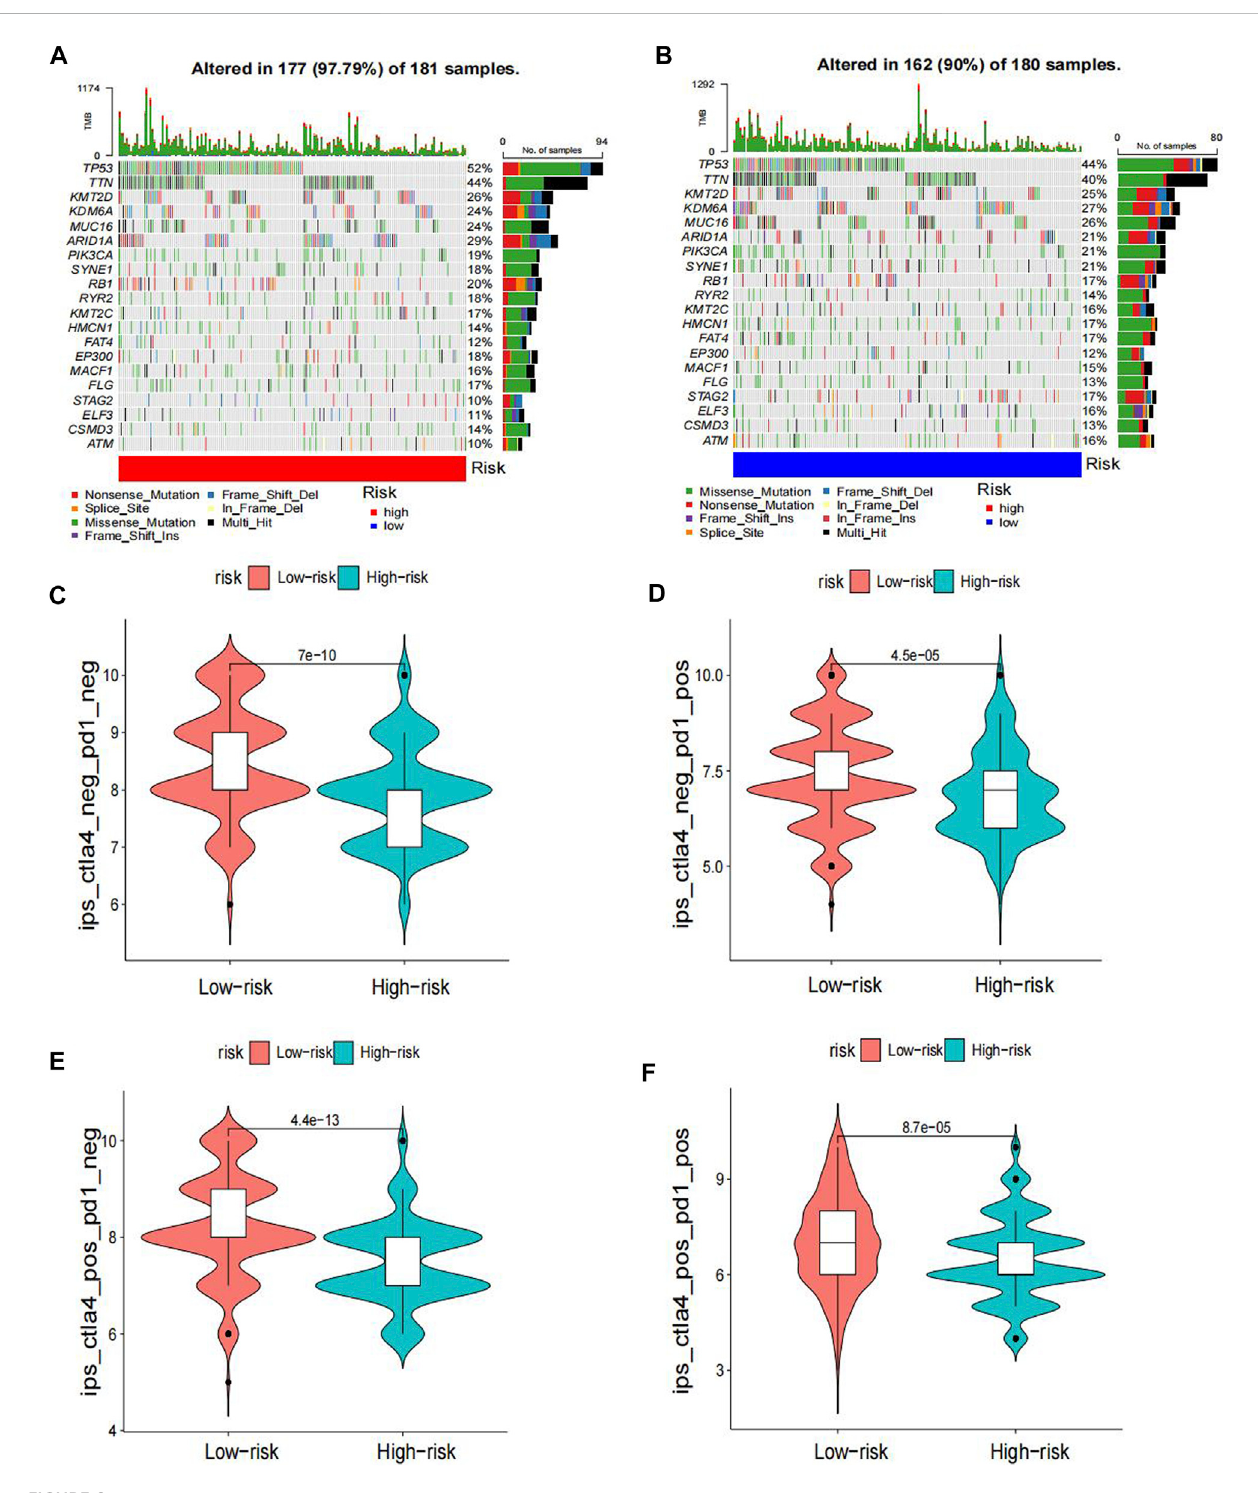
FIGURE 8 Differences in TMB and immunotherapy sensitivity between the two